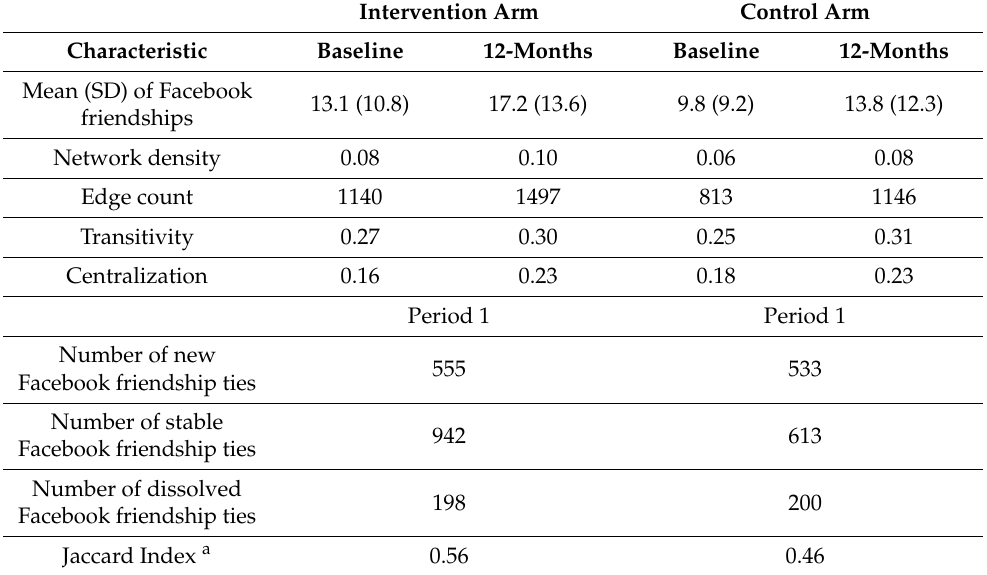
Table 3. Structural properties of the intervention and control arm Facebook friendship networks at baseline and